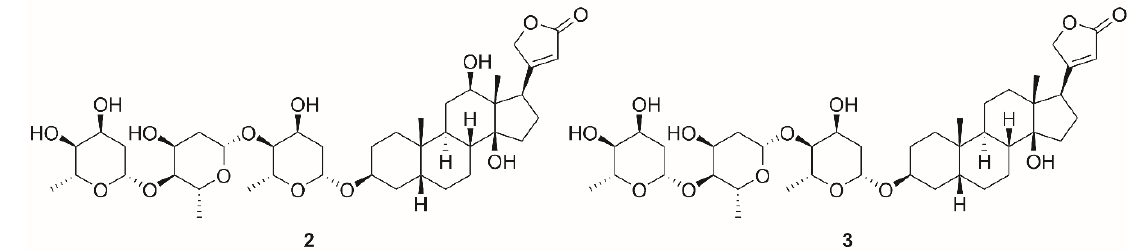
Figure 5. Chemical structures of digoxin ( 2 ) and digitoxin ( 3 ).